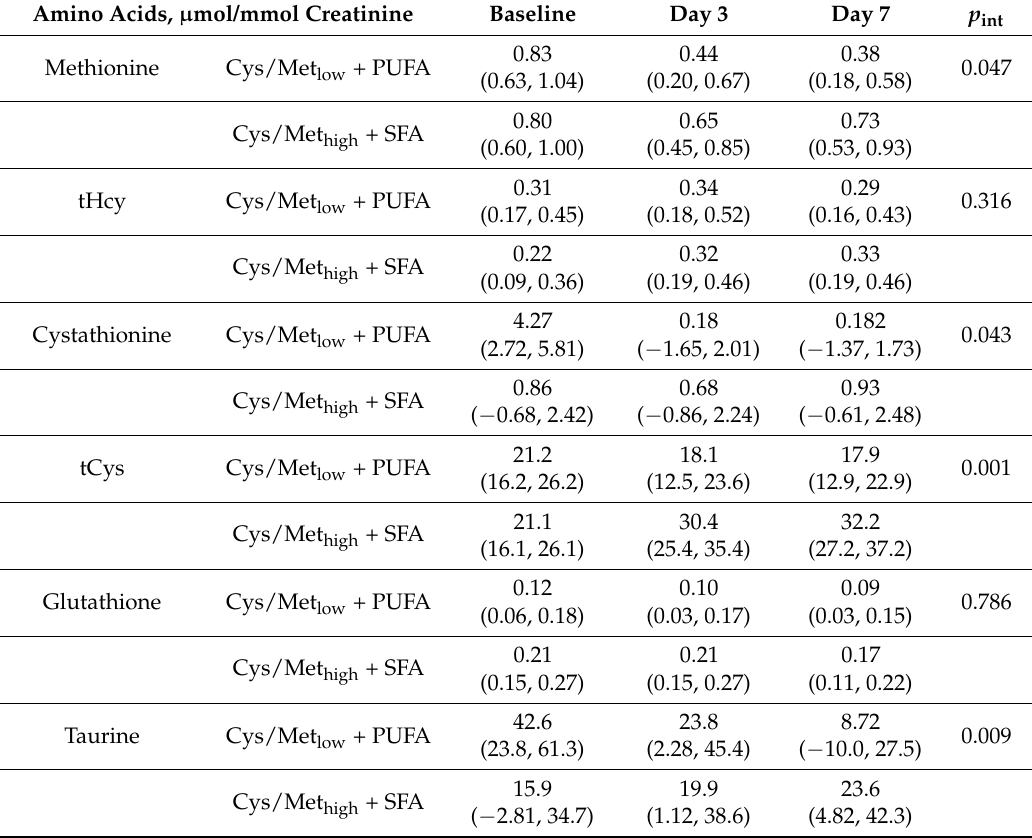
Table 4. Estimated marginal means (95% confidence interval) of urinary concentrations of amino acids and related